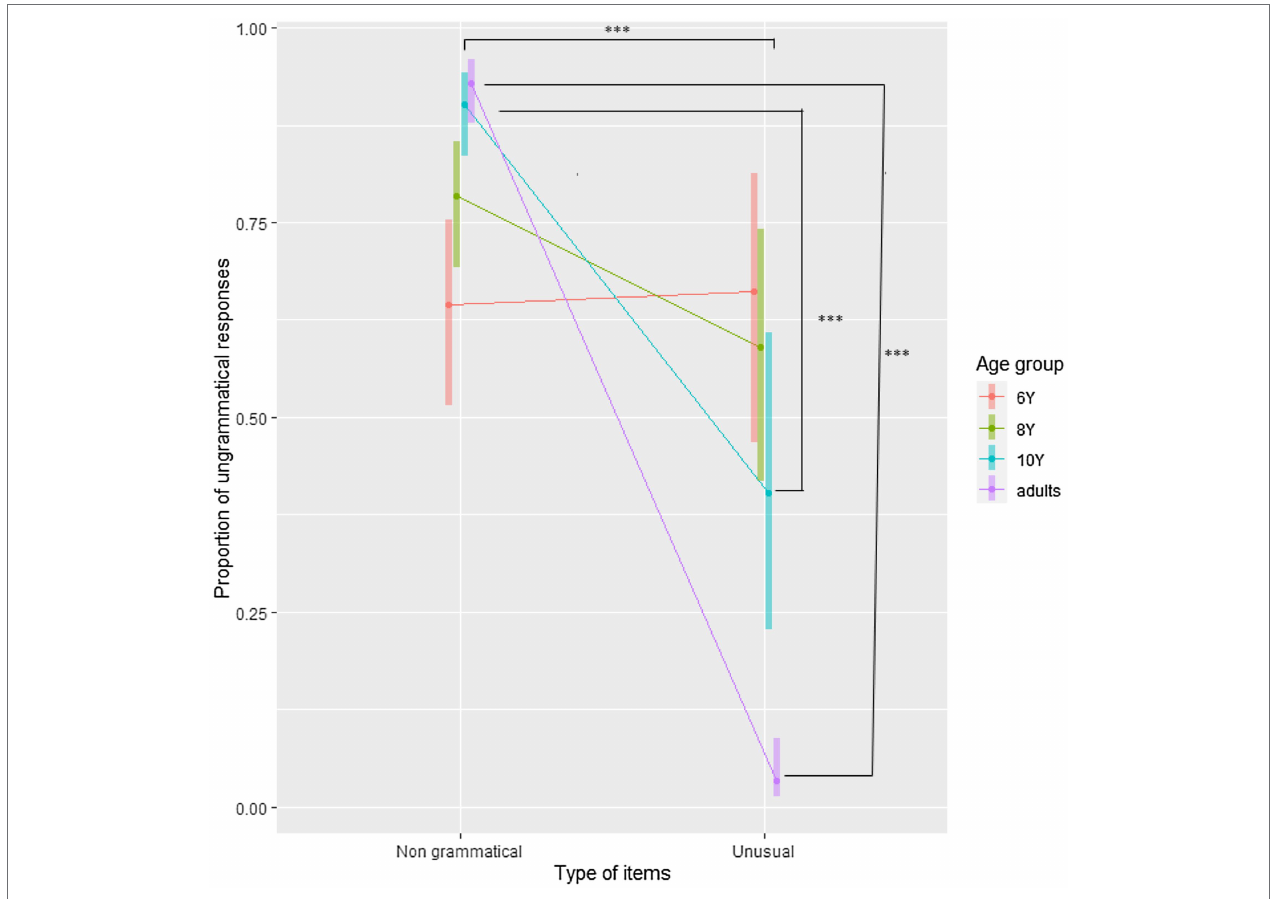
FIGURE 5 | Mean accuracy results plotted separately for Age group and Type of item for “ungrammatical” responses in Experiment 2. Error bars are 95% CI. *** p <